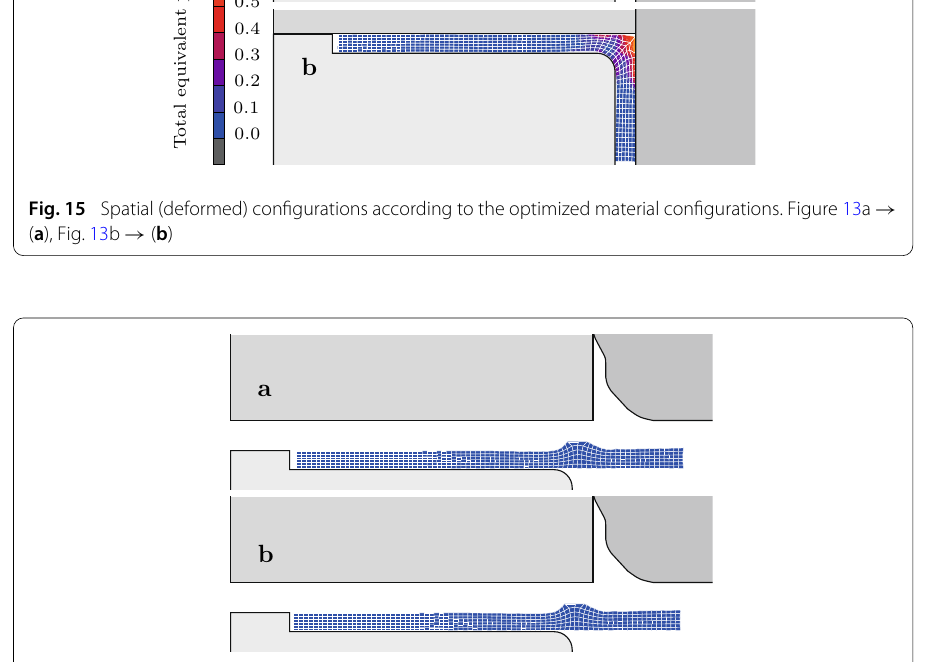
Fig. 16 Optimized material configurations with a constraint of the available design space: configuration a corresponds to the discretized target configuration in Fig. 13a, and b to the discretized target configuration Fig.